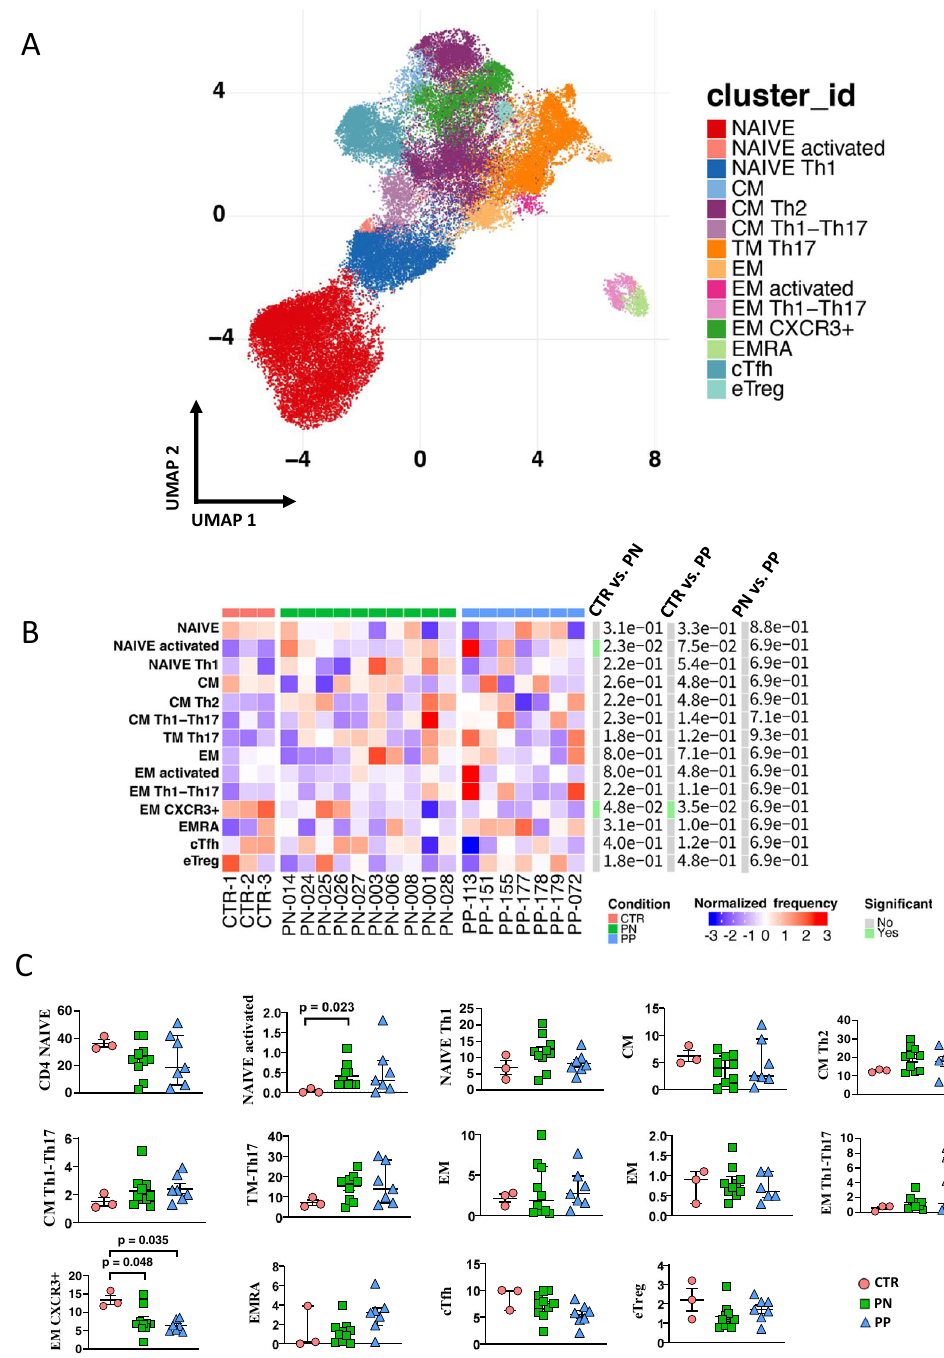
Fig. 3 Reclustering of CD4 + T cells reveals similar distribution of cells between infected or noninfected pregnant women and donors. A Uniform manifold approximation and projection (UMAP) representation of CD4 T-cell landscape. Each color indicates one of the 14 different clusters. CM central memory, TM transitional memory, EM effector memory, EMRA terminally differentiated T cells, cTfh circulating follicular T helper cells, eTREG effector- regulatory T cells. B Differential analysis performed using generalized linear mixed model (GLMM) between nonpregnant women (CTR; bar color: salmon; n = 3), uninfected pregnant women (PN; green, n = 10), and infected pregnant women (PP; azure, n = 7). The heat represents arcsine-square-root- transformed cell frequencies that were subsequently normalized per cluster (rows) to mean of zero and standard deviation of one. The color of the heat varies from blue indicating relative underrepresentation to red indicating relative overrepresentation. Bar and numbers at the right indicate signi fi cant differentially abundant clusters (green) and adjusted p values. C Statistical analysis of the different cell populations identi fi ed as in panel B . Comparison among infected pregnant women (PP) vs. uninfected pregnant (PN) or vs. healthy donors (CTR). The dot plots show the relative abundancies of 14 populations found within CD4 + T cells. Values (dots) for the three conditions are matched with the color used in B . Data represent individual percentage values (dots), median (center bar), and SEM (upper and lower bars). Generalized linear mixed model (GLMM) with Bonferroni correction has been used. The exact p -value is indicated in the fi gure. Source data are provided as a Source Data fi